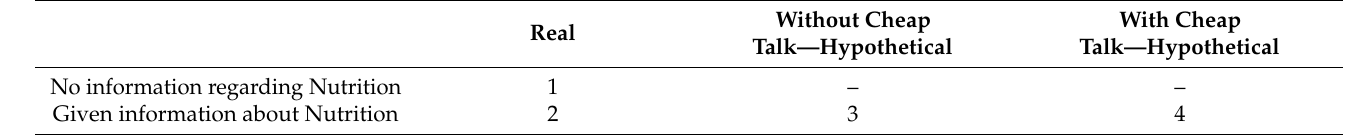
Table 1. Survey Design.